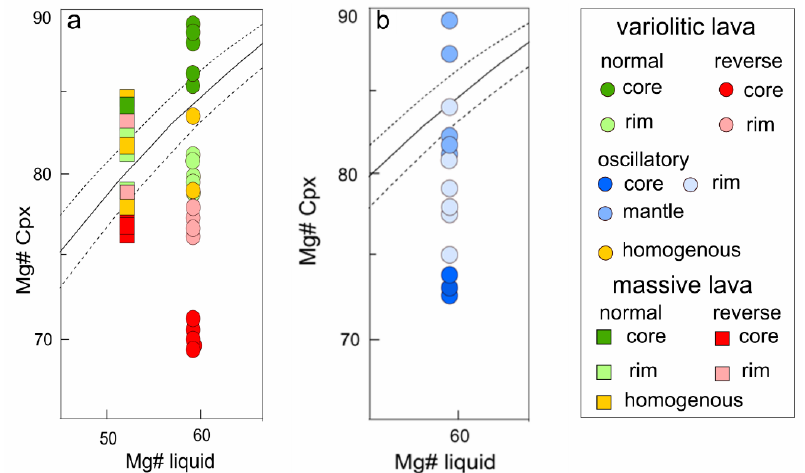
Figure 7. Mineral-melt equilibrium diagrams [44] for clinopyroxene phenocrysts from the variolitic and massive lavas of the Yalguba Ridge with various zoning patterns: normal, reverse, and homogeneous ( a ) and oscillatory for clinopyroxene phenocrysts from variolitic lava ( b ). Dashed curves represent a 2 σ variation ( ± 0.3) of the equilibrium value; the equilibrium value of Kd Fe-Mg = 0.275 ± 0.067 [44] is marked by the solid curve.